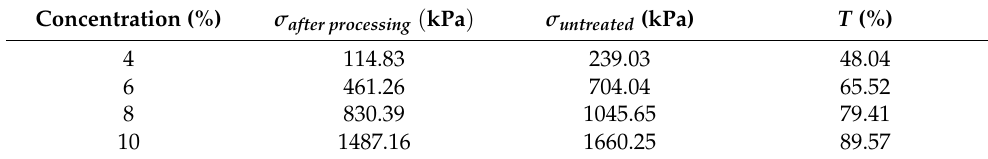
Table 9. The W-OH–Pisha sandstone solid consolidation: σ c , and the unconfined strength ratio: T . Concentration (%) σ after processing ( kPa